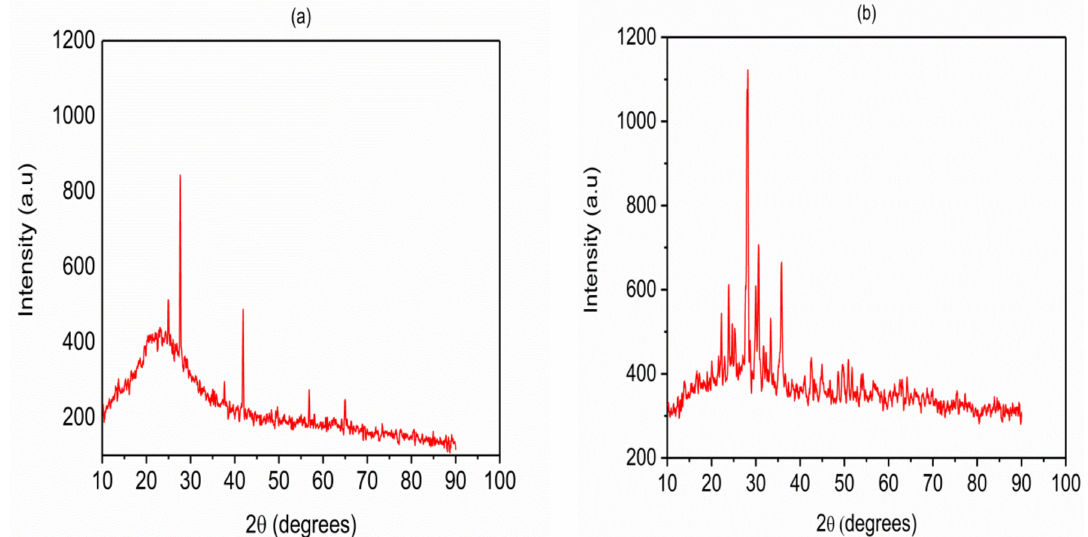
Figure 1. XRD patterns for ( a ) virgin pumice (VPum) and ( b ) virgin scoria (VSco). The greater fraction of amorphous phase(s) in VPum compared with VSco possibly origins from simultaneous rapid cooling and depressurization of high-temperature volcano lava. The depressurization produces bubbles by lowering the boiling point of the lava.